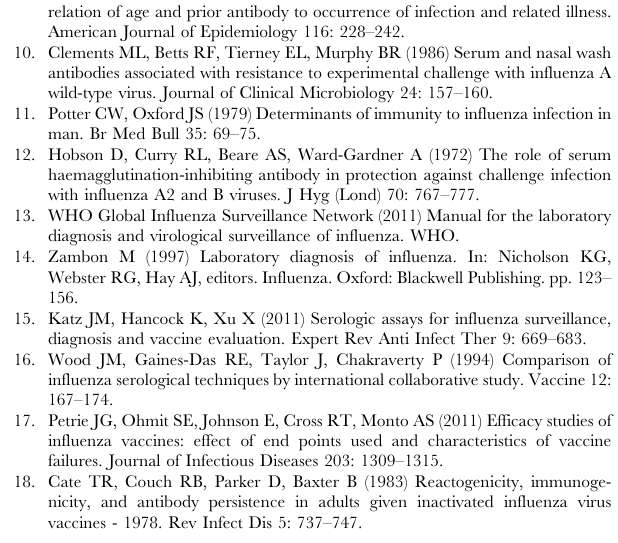
Figure S6 Distribution of observed paired serology in